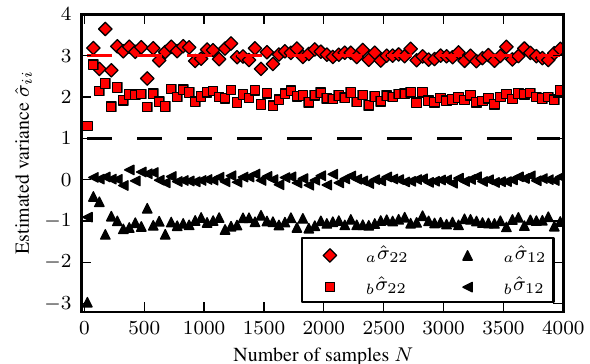
Fig. 5. Estimated variance computed with the correct formula Eq. (23), where the correct covariance σ 23 is known. The solid lines indicate the ± 2SE range around the actual value.